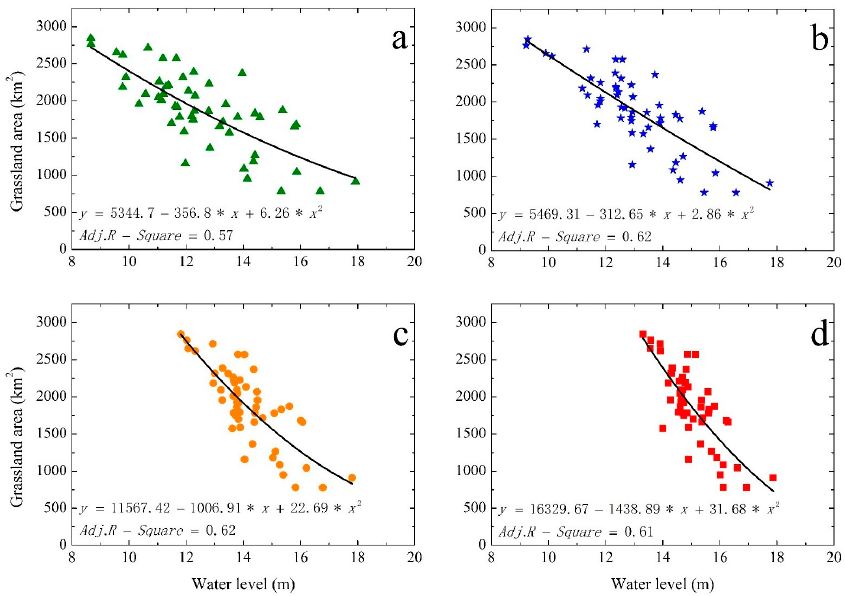
Figure 4. Relationships between grassland area and water level fluctuations (( a ) Xingzi; ( b ) Duchang; ( c ) Tangyin; ( d ) Kangshan) during the rising period.